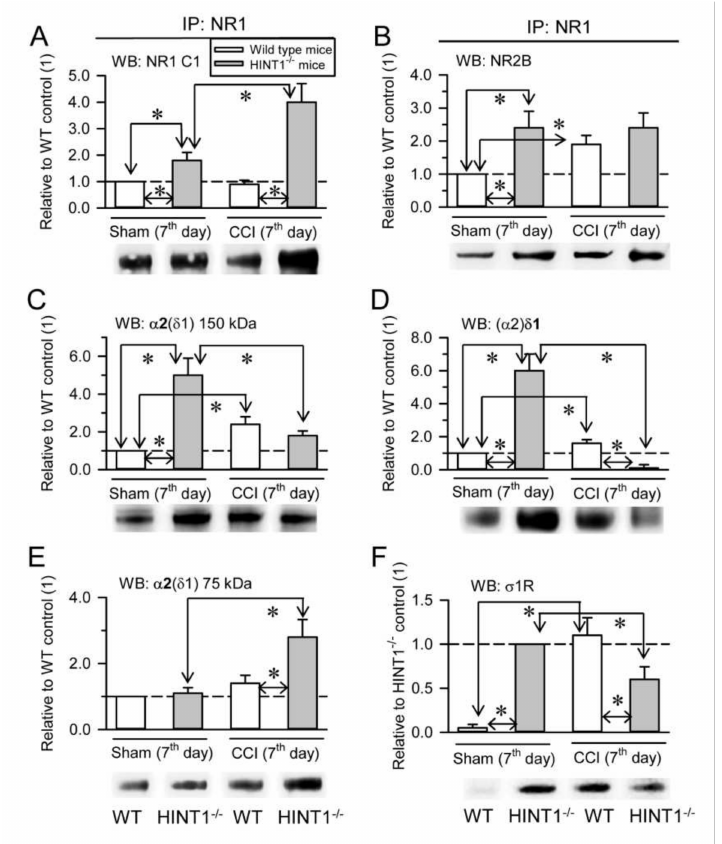
Figure 6. In the absence of HINT1 proteins, CCI promotes the destruction of α 2 δ 1-2 proteins when associated to NMDARs. ( A ) 129 WT sham-operated ( n = 7), 129 WT CCI ( n = 7), 129 HINT1 − / − sham ( n = 7), and 129 HINT1 − / − CCI mice ( n = 7) were sacrificed 7 days after surgery to obtain PAG synaptosomal fractions. NR1 subunits were immunoprecipitated (IP) from the solubilized membrane preparations and the presence of co-precipitated ( A ) NR1 subunits carrying cytosolic C1 segment, ( B ) NR2B subunits, ( C ) α 2( δ 1) proteins of 150 kDa, ( D ) ( α 2) δ 1 peptides, ( E ) α 2( δ 1) proteins of 75 kDa, and ( F ) σ 1Rs were assessed in Western blot (WB). The bars represent the mean ± SD of three measurements and the data are shown relative to the 129 WT sham mice (assigned the arbitrary value of 1). Determination of σ 1R: due to the weak signal observed in 129 WT sham mice, the data were assessed relative to the 129 HINT1 − / − sham mice (arbitrary value of 1). The arrows refer to the comparison and * indicates significant difference of the CCI group relative to the 129 WT or 129 HINT1 − / − control group: p <